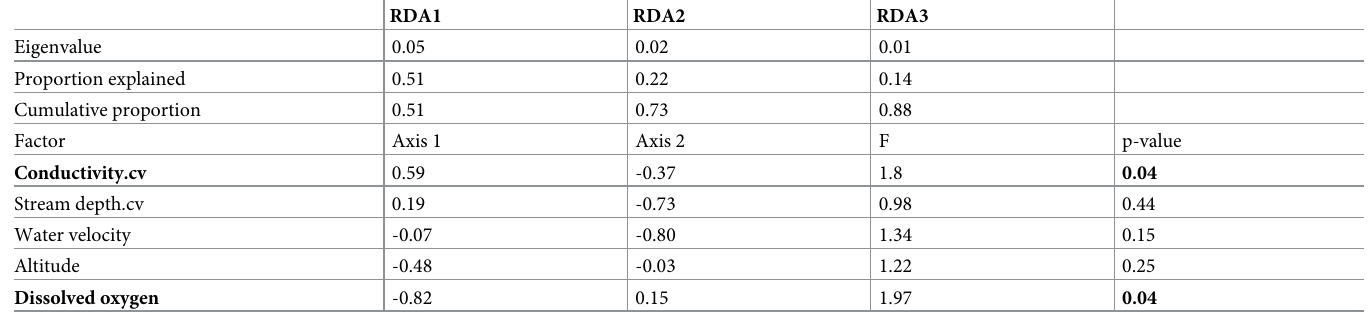
Table 7. Eigenvalues and proportion explained by the first three axes of RDA along with axis loadings of environmental variables on first two RDA axes along with their significance based on permutation tests (number of permutations = 999) in WB. Values lesser than 0.05 (in bold) are considered as significant explanatory factors for the community structure.